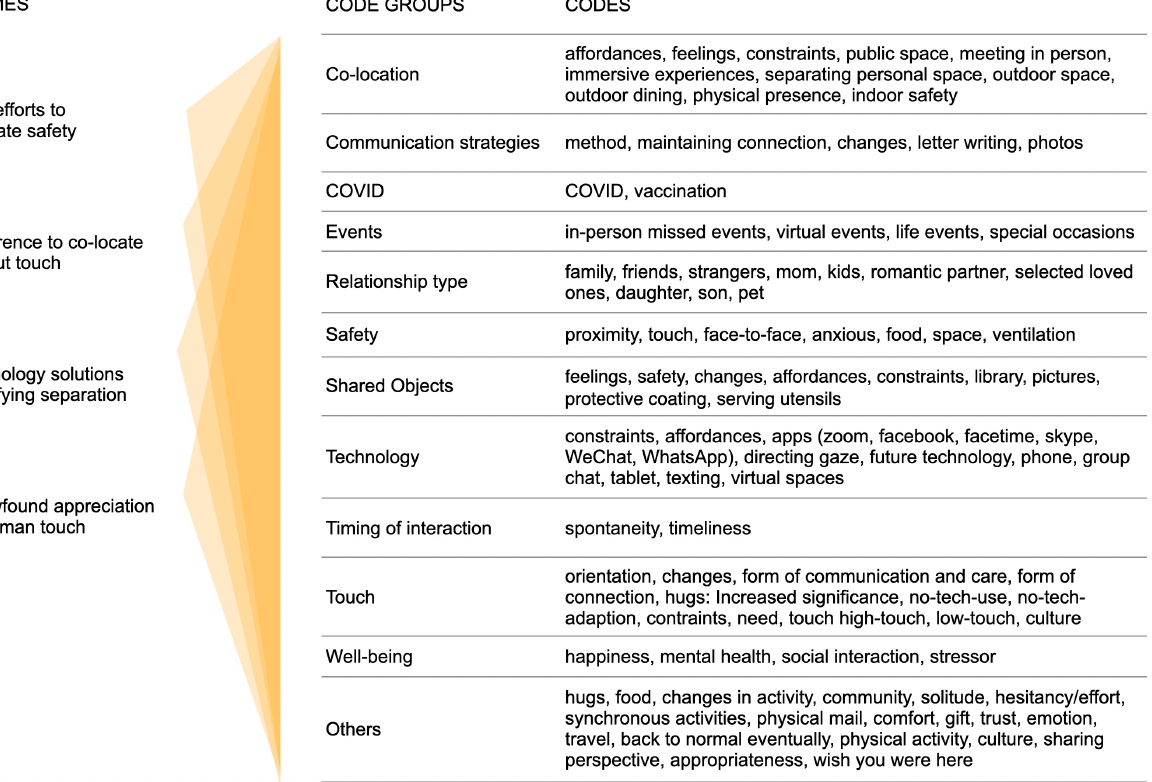
Figure 2. Four themes derived from organizing codes into code